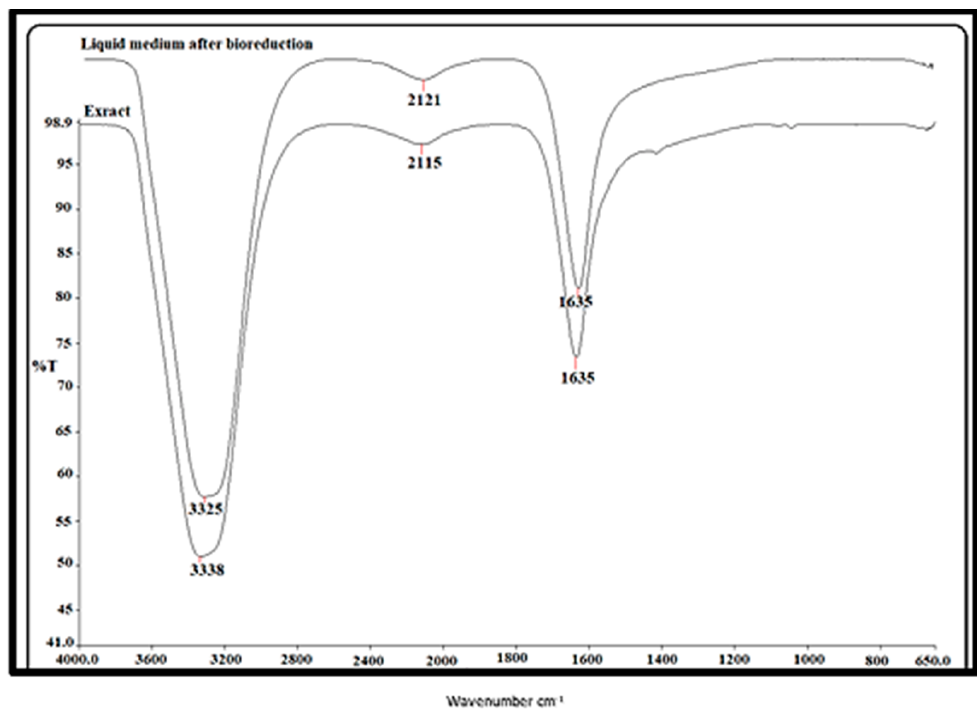
Figure 4. FTIR spectra of Amygdalus communis leaf extract and biogenic functionalized gold nanoparticles.